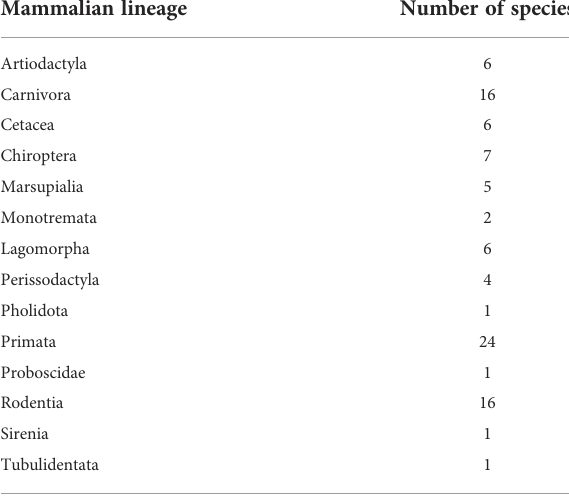
The full list of species and sequence accession numbers are given in Supplementary Table